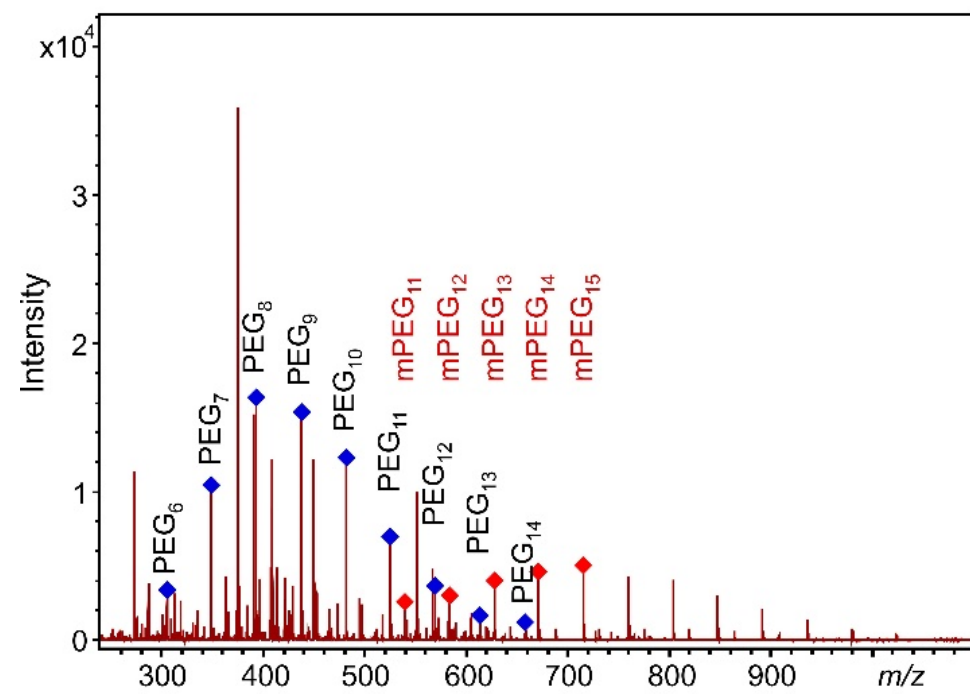
Figure 5. MALDI-TOF mass spectrum of a urine sample from a volunteer following administration of PEG 400 spiked with 50 µL of mPEG as internal standard. The peaks marked by red symbols denote the mPEG oligomer series.